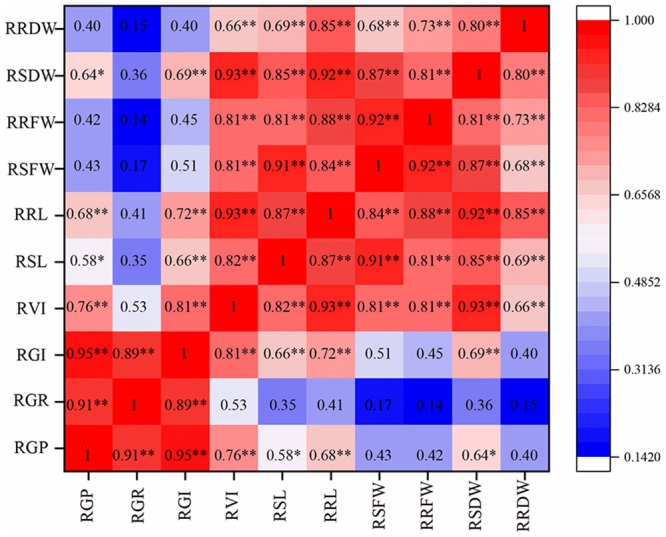
Heat map of correlations among germination traits under saline conditions.RGP: relative germination potential; RGR: relative germination rate; RGI: relative germination index; RVI: relative vigor index; RSL: relative shoot length; RRL: relative root length; RSFW: relative shoot fresh weight; RRFW: relative root fresh weight; RSDW: relative shoot dry weight; RRDW: relative root dry weight. A darker red color indicates a larger correlation coefficient, and a darker blue color indicates a smaller correlation coefficient. * and ** indicate significant correlations at p < 0.05 and p < 0.01, respectively.